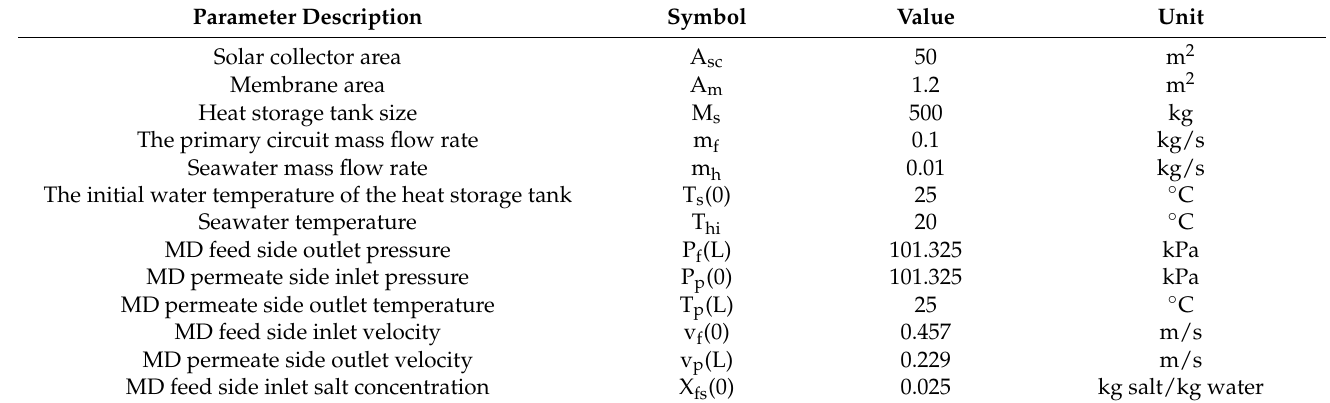
Figure 2. The environmental data of the Taichung area. Table 2. The operating conditions of preliminary simulation for the solar-heated membrane distilla- tion